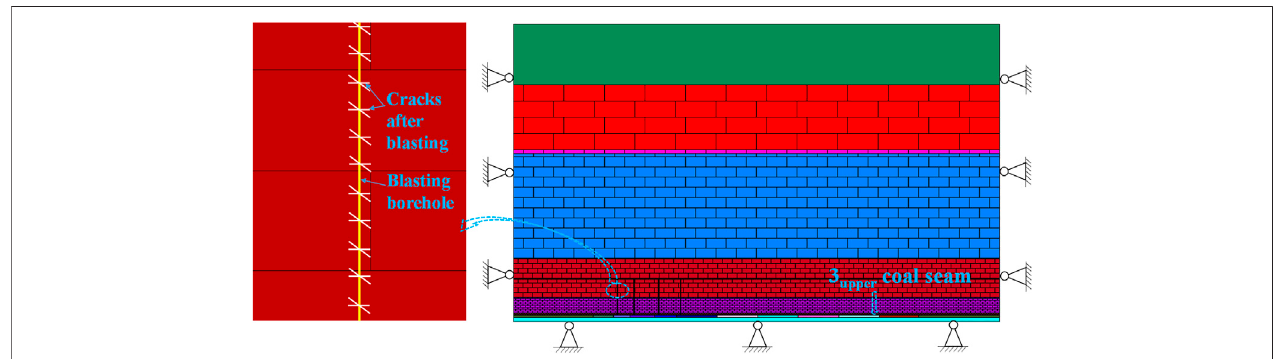
FIGURE 8 | Excavation and the blast hole